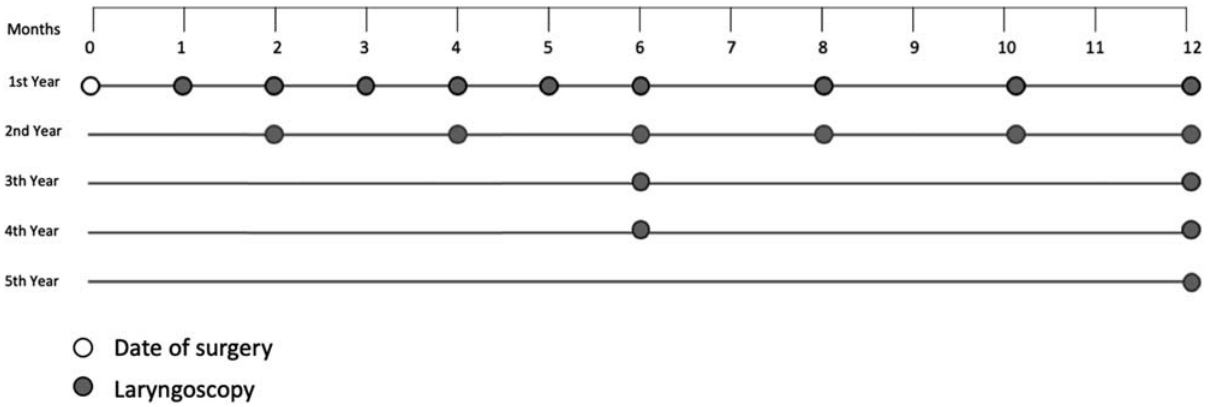
Table 2: Follow - up